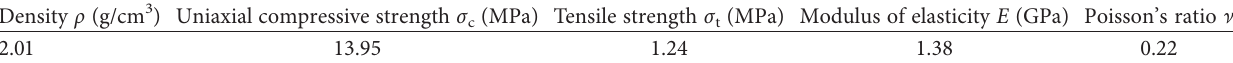
Table 3: Main physical and mechanical properties of silty